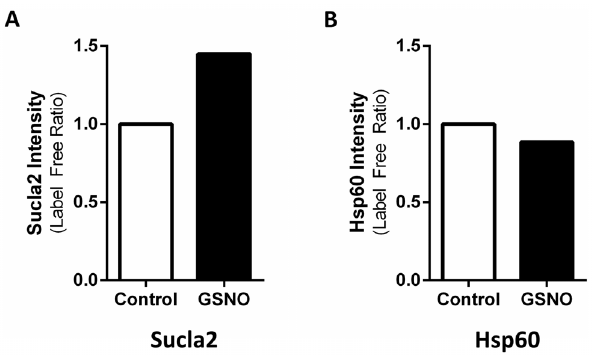
Figure 4. SNO alters the binding of GAPDH to Sucla2, but not Hsp60. Sucla2 ( A ) and Hsp60 ( B ) levels from GAPDH co-immunopre- cipitation using mitochondrial fractions of hearts subjected to control or GSNO perfusion. Binding was assessed using label-free peptide quantification